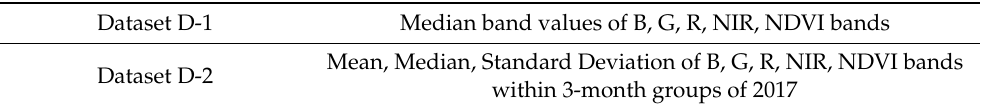
Table 1. Statistical dataset derived from Landsat-8 OLI 2017 images for image